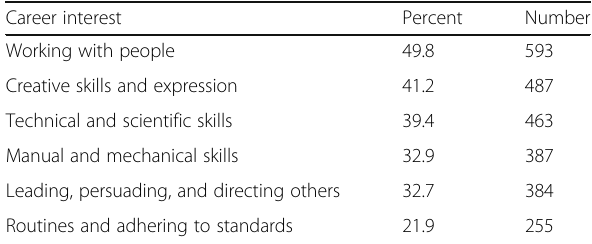
Table 3 Career interests rated by grade 7 and 9 students in Atlantic Canada as being in the top 2